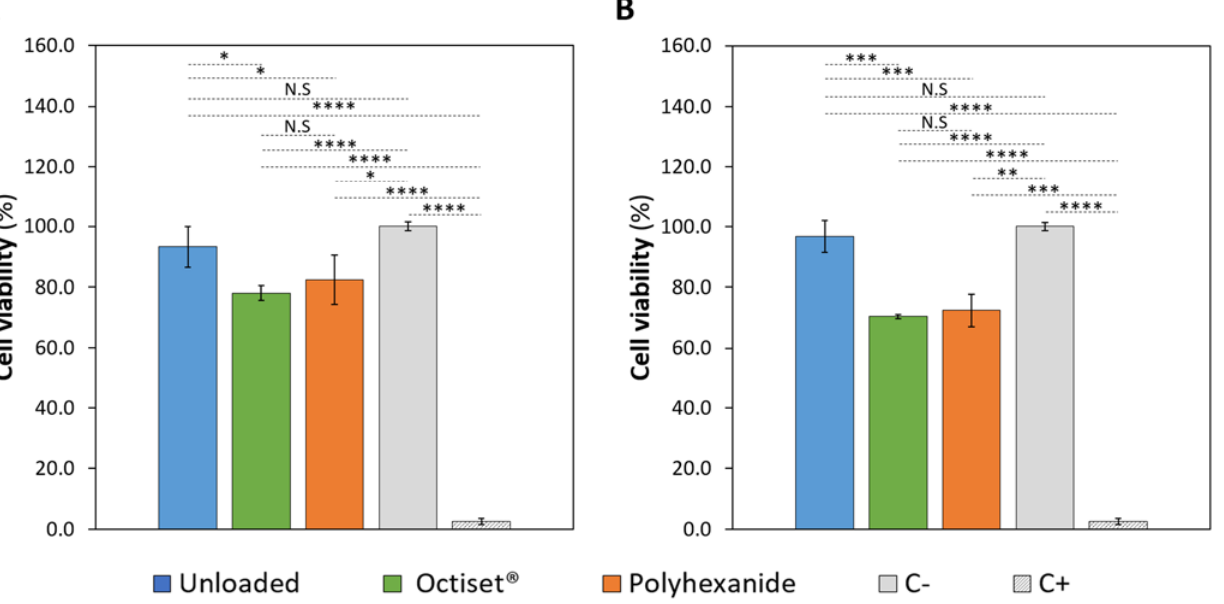
Figure 9. Viability of fibroblasts after growth in culture medium containing non-loaded and drug- loaded hydrogels with formulation CS ( A ) and C ( B ). Error bars correspond to ± standard deviations (n = 4). Statistical analysis was performed using the Student t-test or Wilcoxon signed-rank test, with significance set at * p < 0.05, ** p < 0.01, *** p < 0.005, **** p < 0.001. N.S. = not significant.